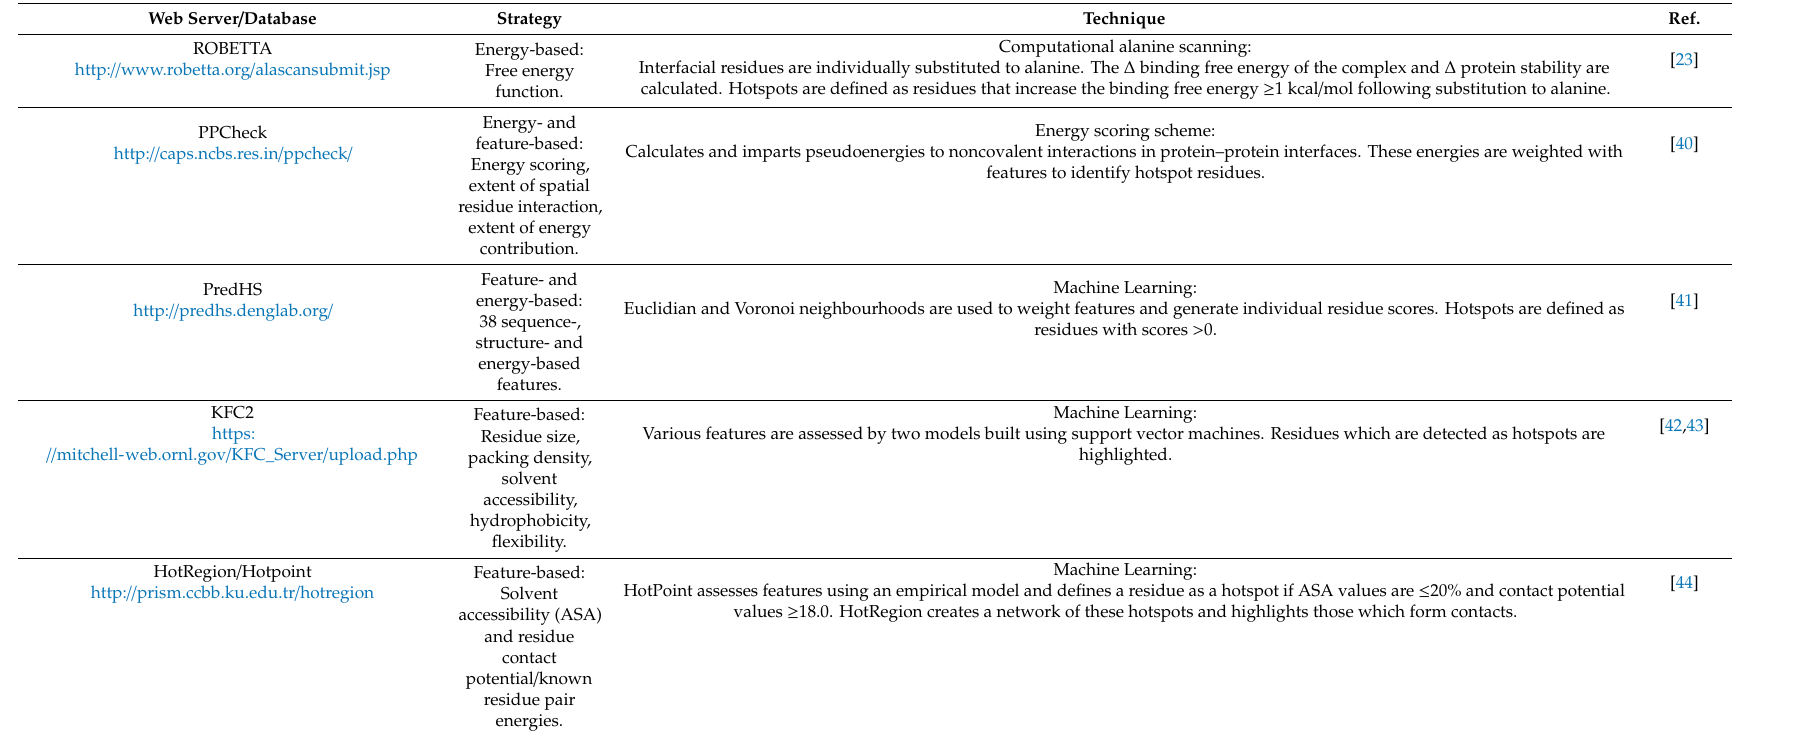
Table 1. The web servers and databases used for the prediction of hotspot residues in this